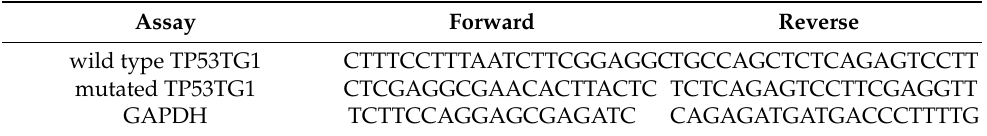
Table 1. List of primers used for